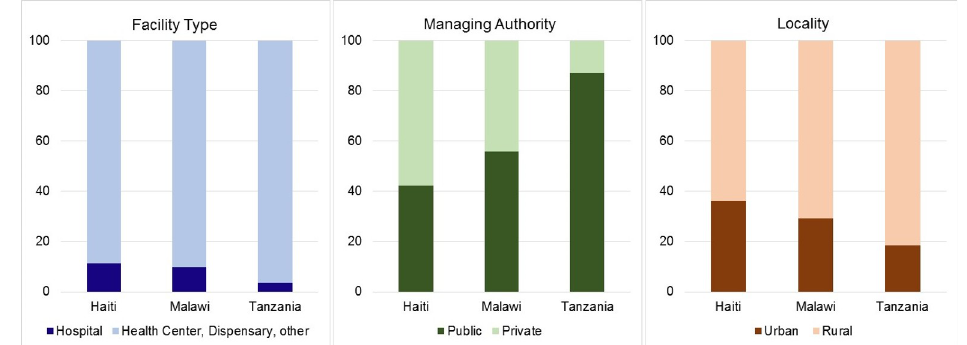
Fig 1. Percent distribution of facilities with family planning services by facility